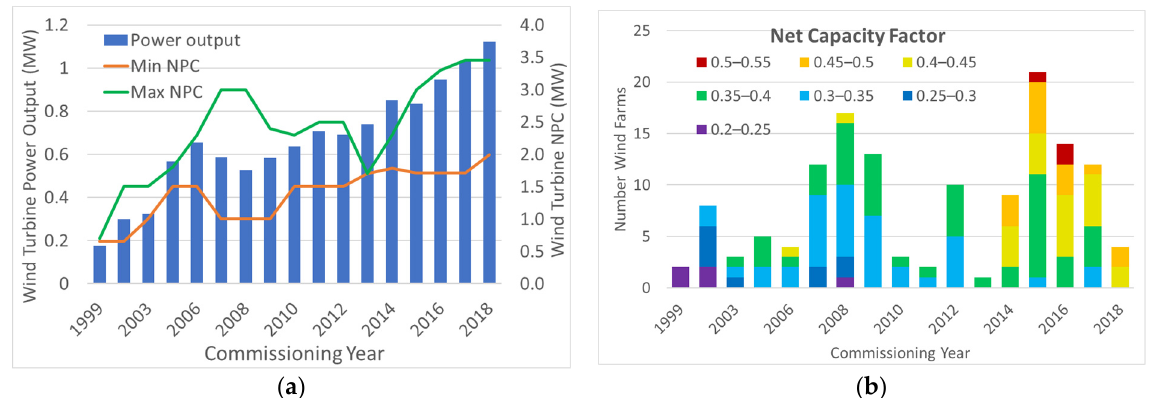
Figure 13. Distance from wind turbines in Texas to closest major highways over time. ( a ) Number of wind turbines. ( b ) Maximum and average distance from wind turbines.